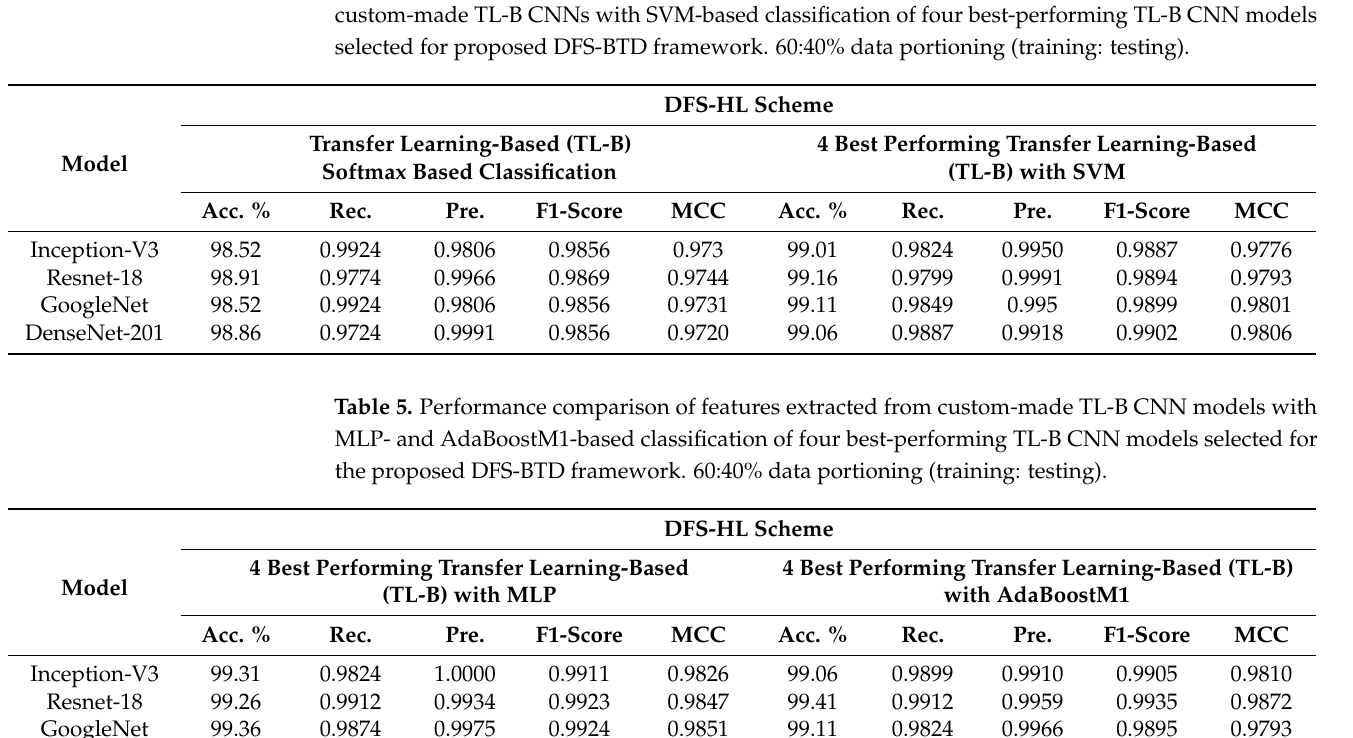
Table 4. Performance comparison of Softmax probabilistic-based and deep feature extracted from